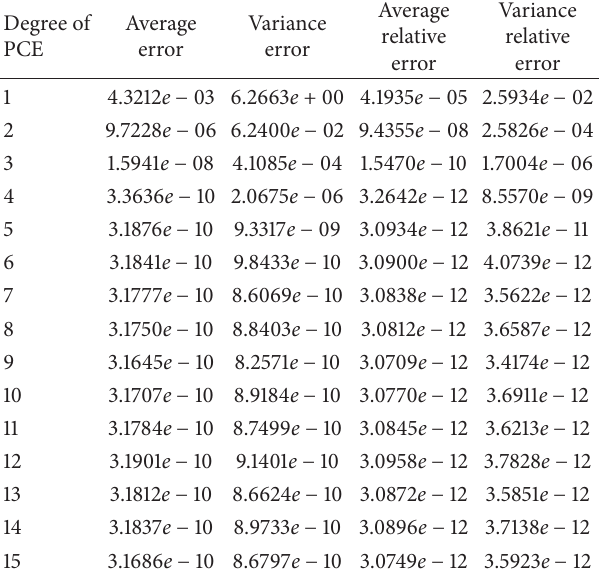
Table 3: Absolute error of the average and the variance of PCE approximation of GBM at time 𝑇 = 1 (whose parameters are 𝑟 = 3 %, = 100 ) for higher precision at 𝜎 = 15 %, and starting value 𝑆 0 computing {𝑆 𝑇,𝑗 } 𝑁 𝑗=1